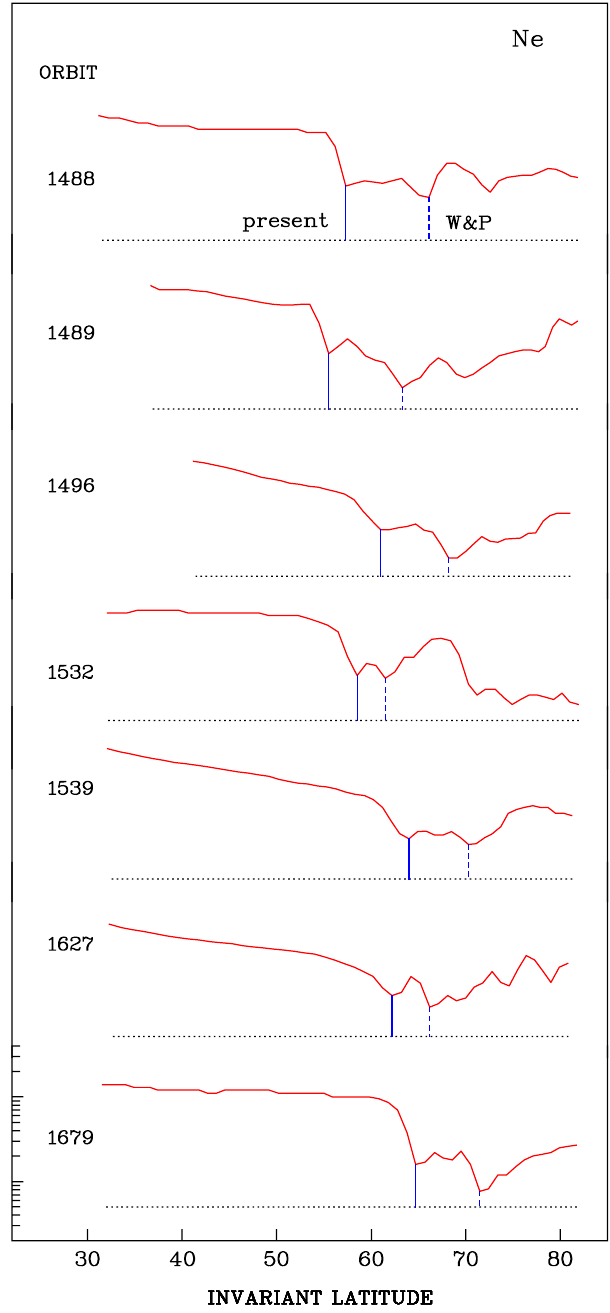
Fig. 13. Examples of more complicated trough structures. The gen- eral format of data presentation corresponds to that of Fig. 1. Shown are seven latitudinal profiles of the electron density as obtained by the DE-2 satellite between 12 November and 24 November 1981. The respective orbit numbers are given to the left of each profile. The location of the poleward boundary of the equatorward trough wall (i.e. latm ) is indicated by the solid blue line. This location is compared to the position of the trough minimum (dashed blue line) as identified in the study of Werner and Pr¨olss (W&P,